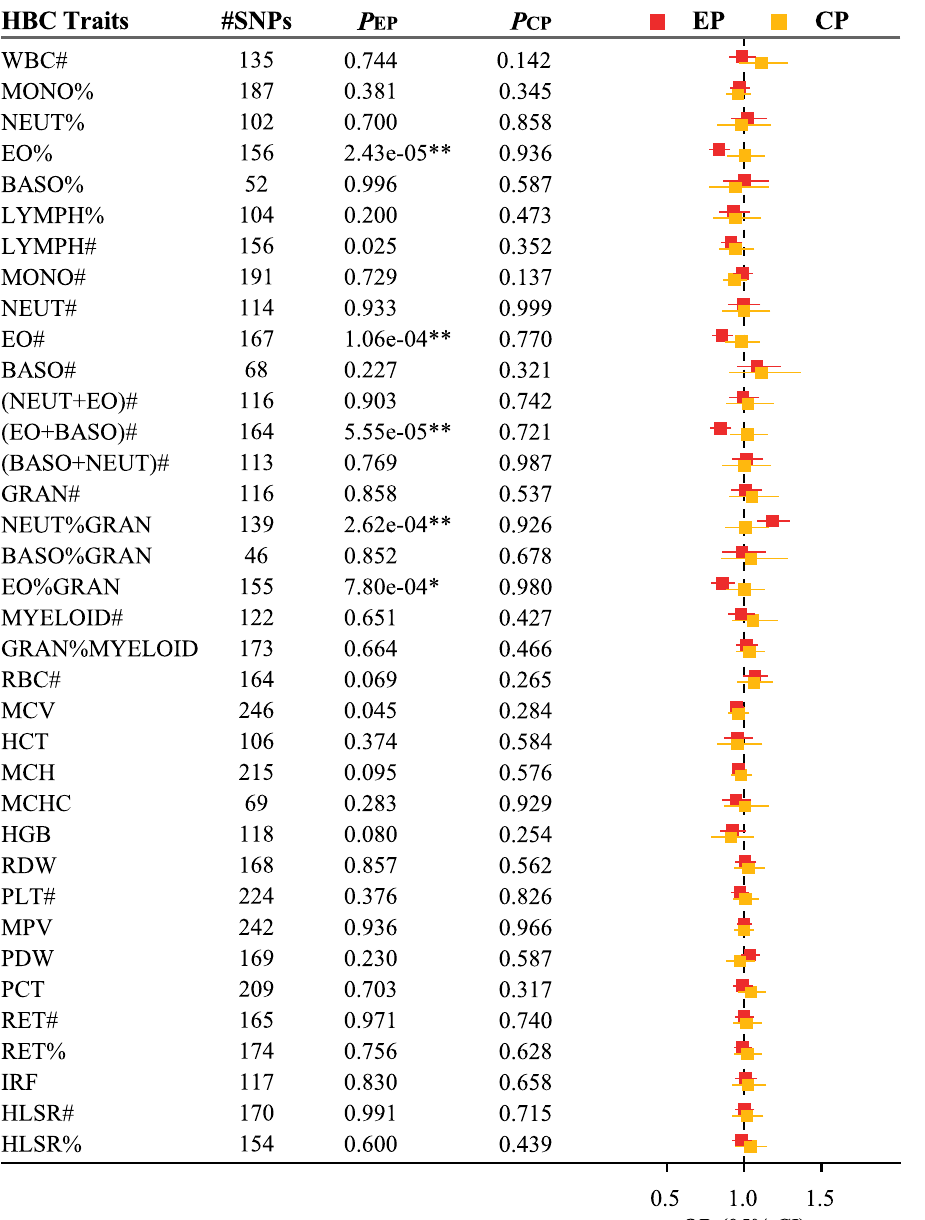
Figure 2. Mendelian randomization estimates of HBC traits on EPs and CPs. Associations were assessed using the random-effect IVW method. Results are expressed as ORs and 95% CIs per 1 SD of each HBC trait.